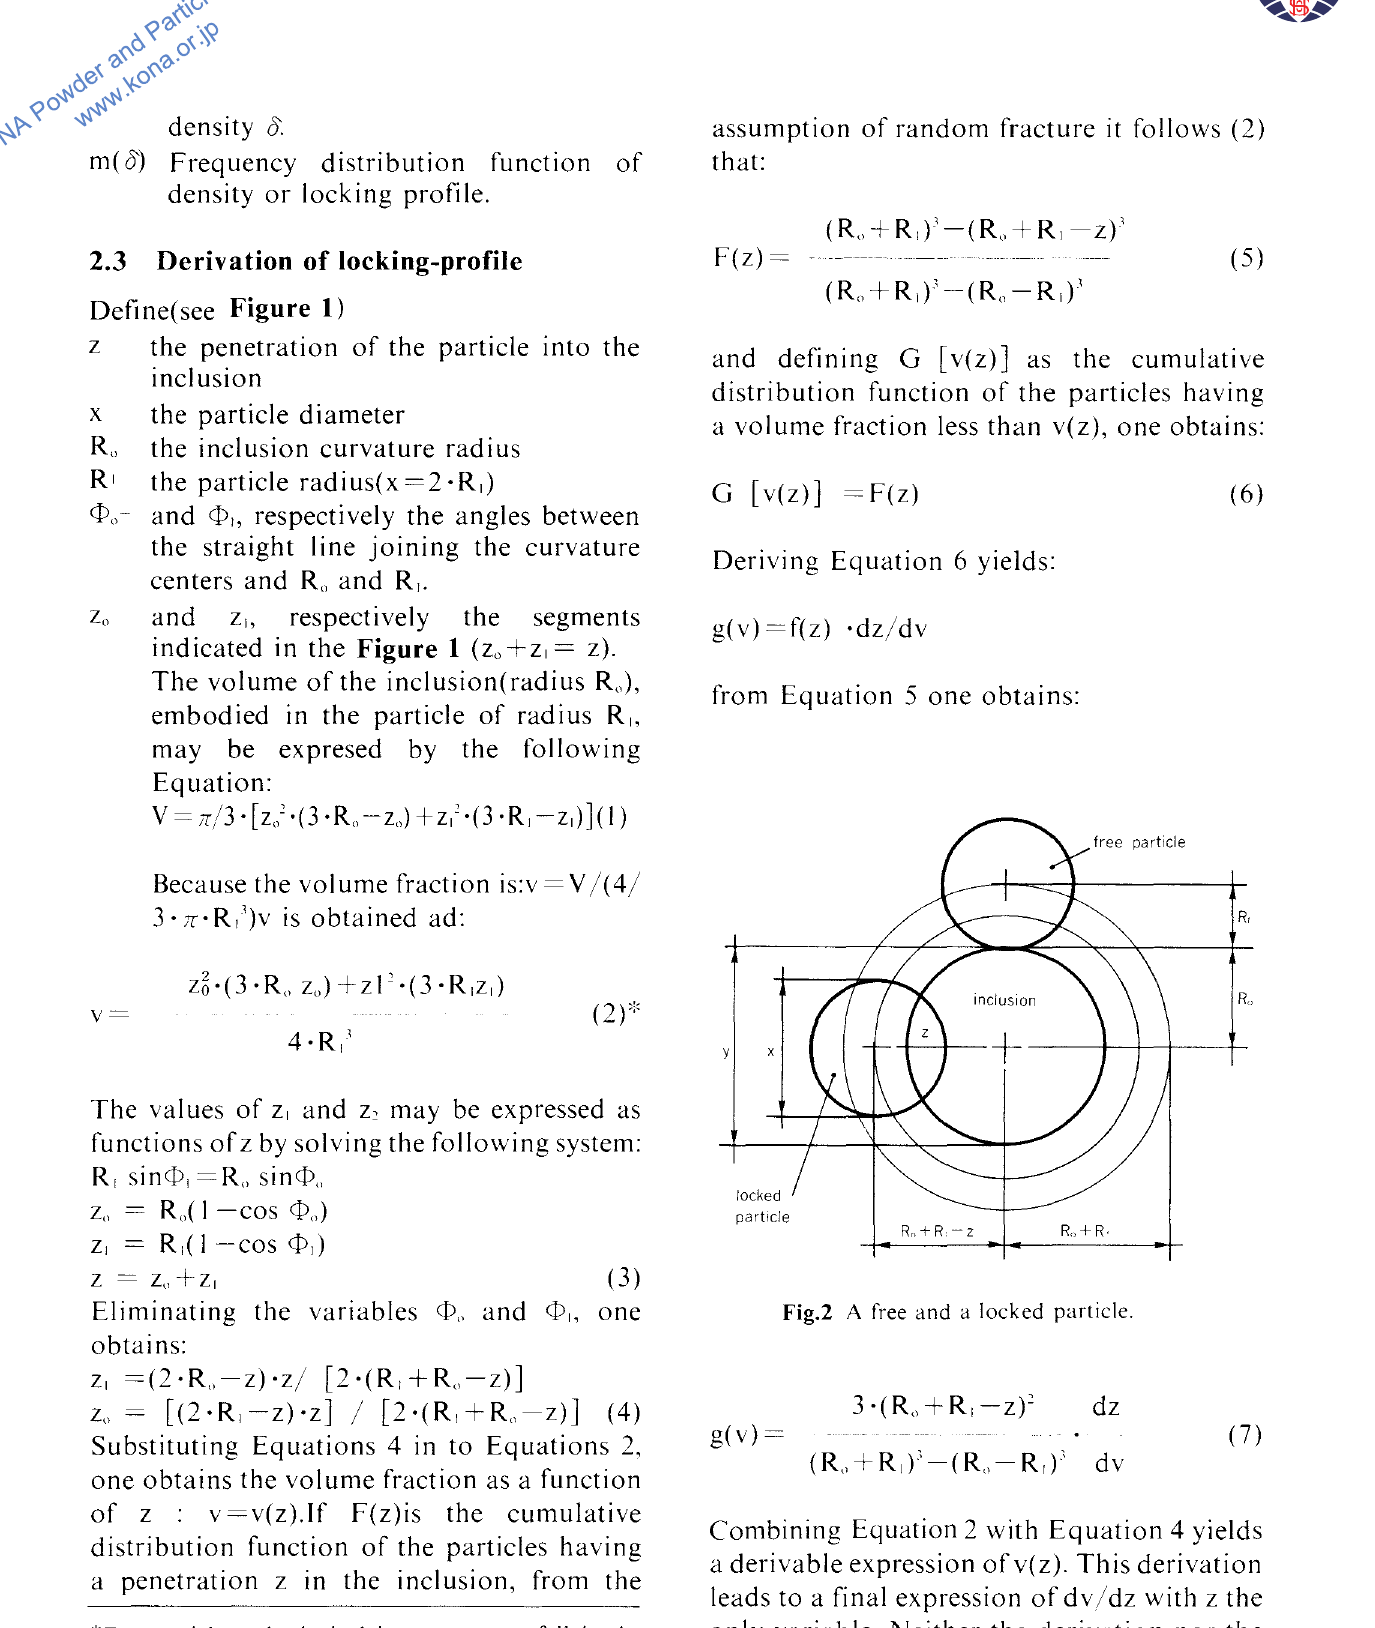
Fig.2 A free and a locked